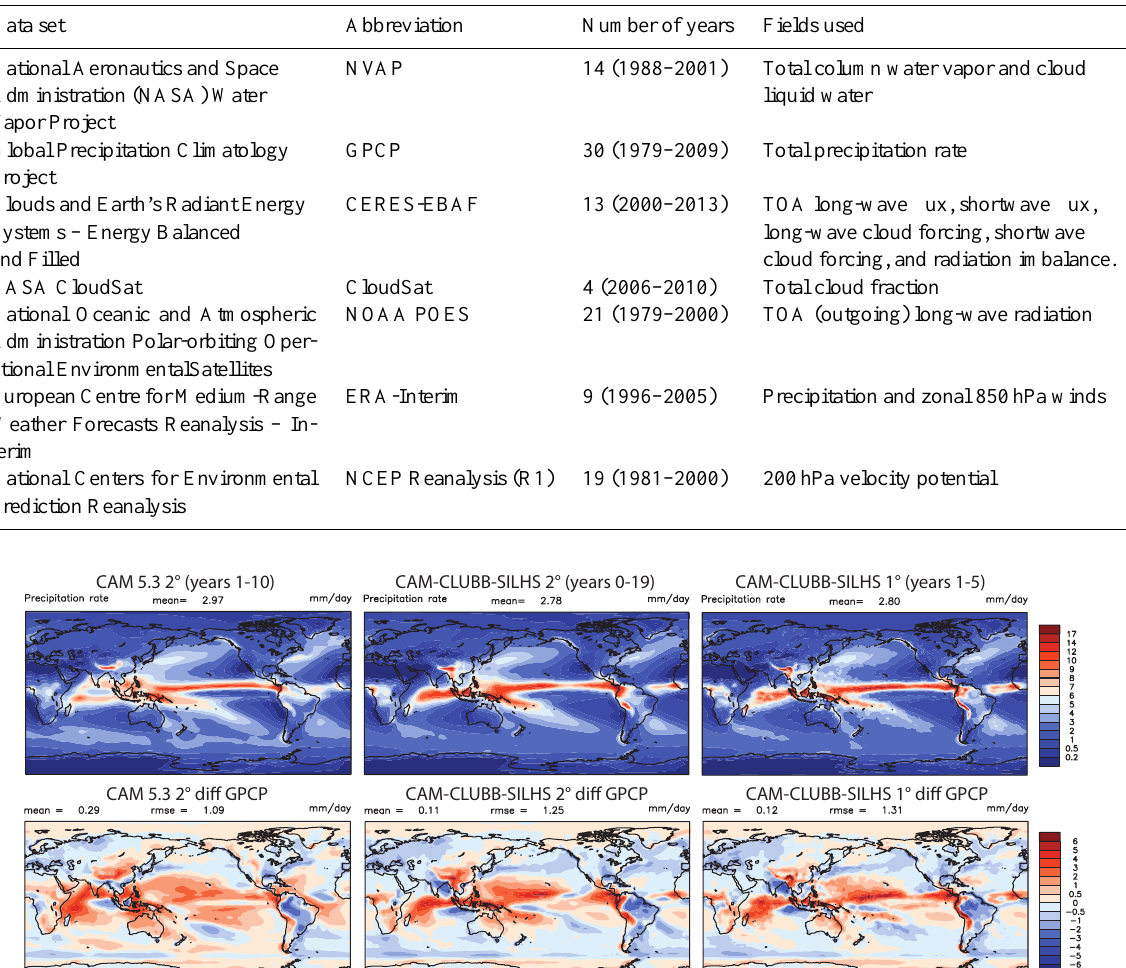
Table 3. Information about observational data sets used for comparison in this paper. More information about each of these can be found on the website for the National Center for Atmospheric Research (NCAR) Climate Data Guide at https://climatedataguide.ucar.edu/.